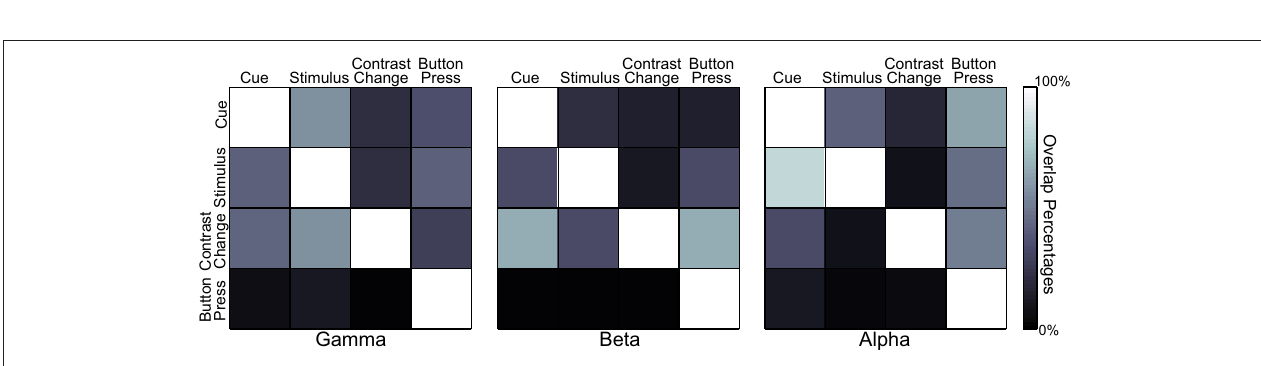
FIGure 7 | Overlap percentages of accumulated activations across three spectral bands at four task stages. A color-coded element at row i and column j represents the percentage of the activations in band i that are present in activations of band j at a particular stage of the task.